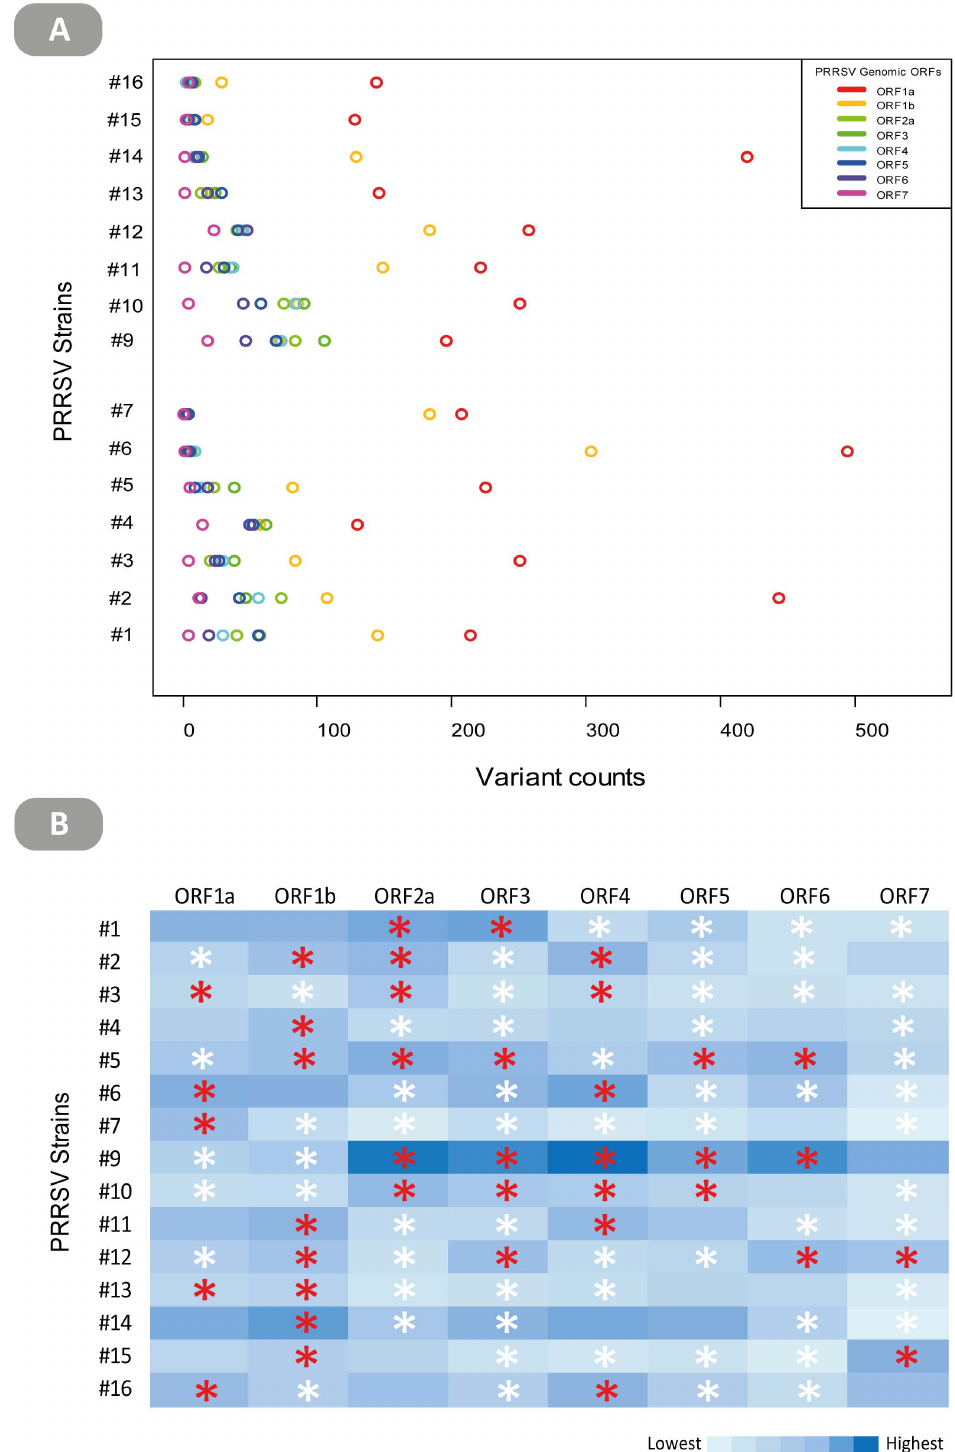
N ) circles [40,41]. Results only from unanimous predictions is summarized based on the confidence of predictions in Figure 4. The median value for consensus predictions (out of total predictions) amongst